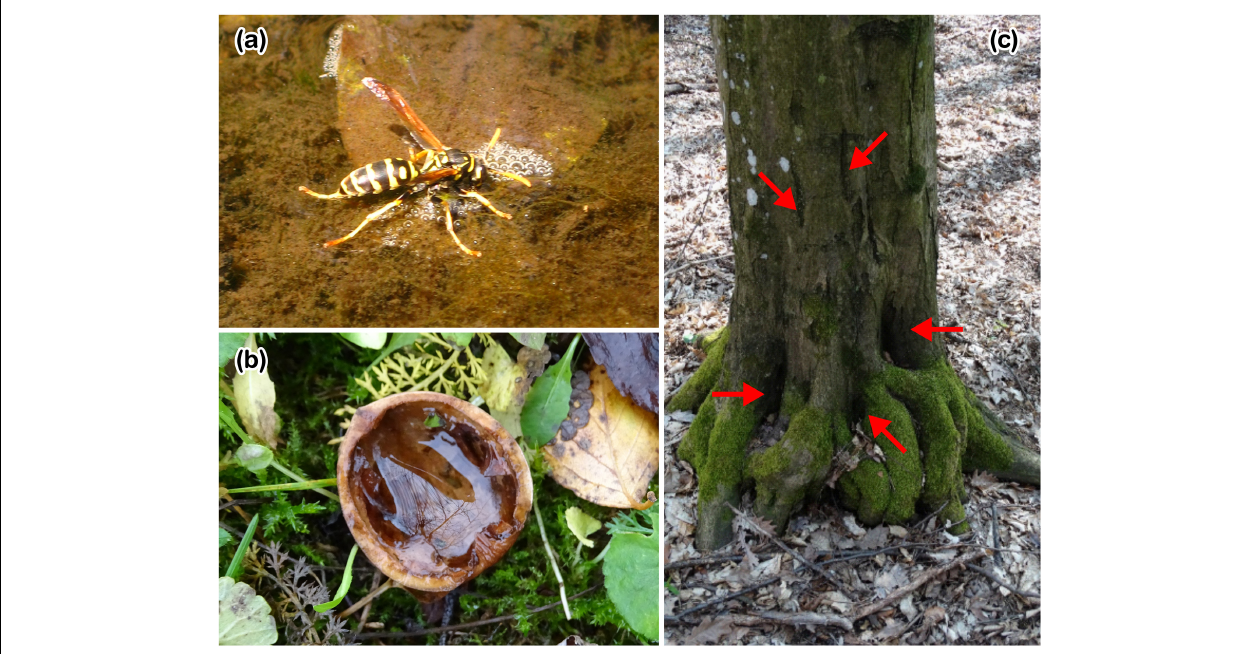
FIGURE 6 | Photographs of potential vectors and microhabitats that may act as sources (or sinks) for stemflow conidia. (a) an insect drinking from the foam floating on a creek, where Ingoldian fungi are common. It is possibly a way to transport these conidia from streams to the tree canopy. (b) Rainwater accumulated in a walnut shell (i.e., a “micro-phytothelma”) between trees and a creek, containing spores of Ingoldian and dendronatant fungi. It may enable a mesoscale spore dispersal by rainsplash and throughfall between a network of such telmata (nutshells, pots, and snail shells, etc.). (c) Red arrows point to a network of dendrotelmata found in Õrség, Hungary on Alnus and Carpinus trees, which can hypothetically provide vertical mesoscale transport of spores (Credit for all photos: D. Magyar).